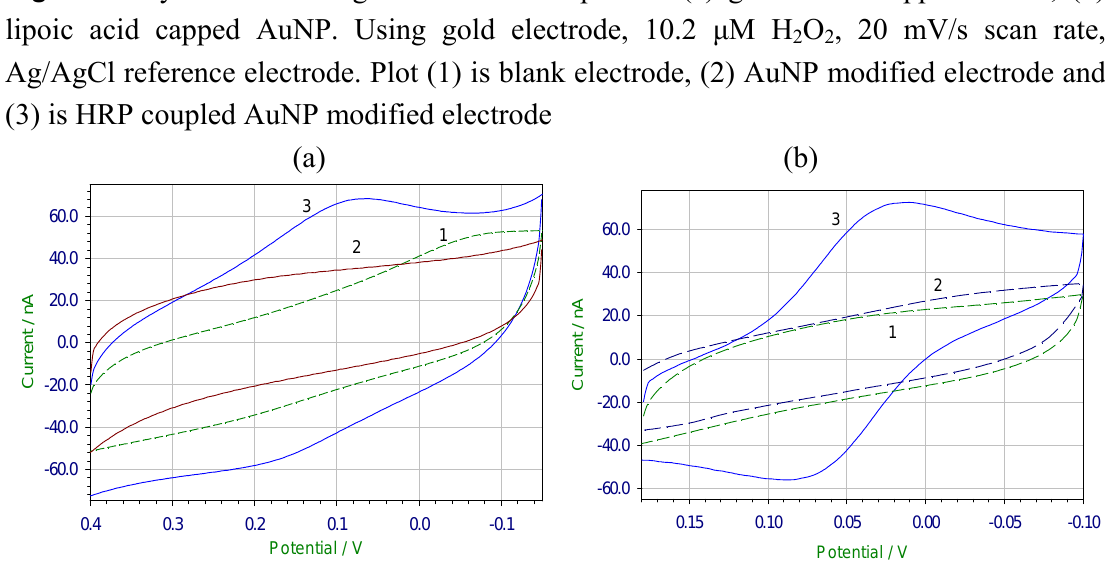
O , 20 mV/s scan rate, 2 2